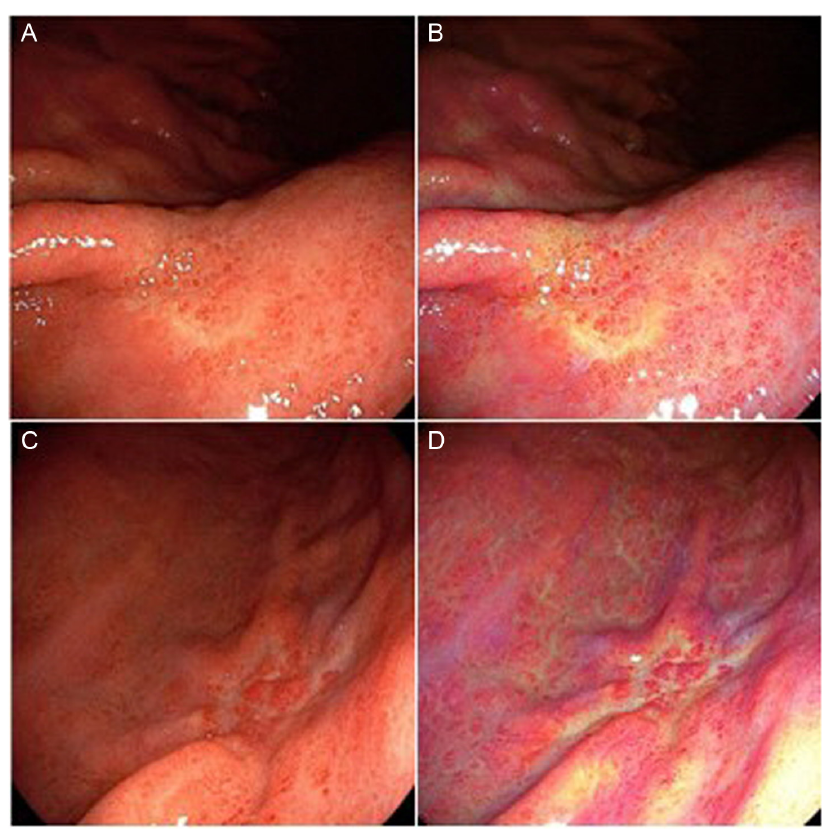
Figure 4. Representative endoscopic images of undifferentiated-type early gastric cancer. (A) WLI shows an ill-defined lesion at the posterior and greater curvature side in the gastric upper body. (B) On LCI, the lesion appeared as an orangish, depressed lesion with reddish-colored area in the central portion surrounded by purple-colored metaplastic mucosa. (C) A 2.5-cm-sized depressed lesion with reddish central area located in the posterior wall of the gastric mid body shown on WLI. (D) This lesion appeared orange-red in a background of diffuse reddish mucosa associated with Helicobacter gastritis using LCI. LCI, linked color imaging; WLI, white light imaging.